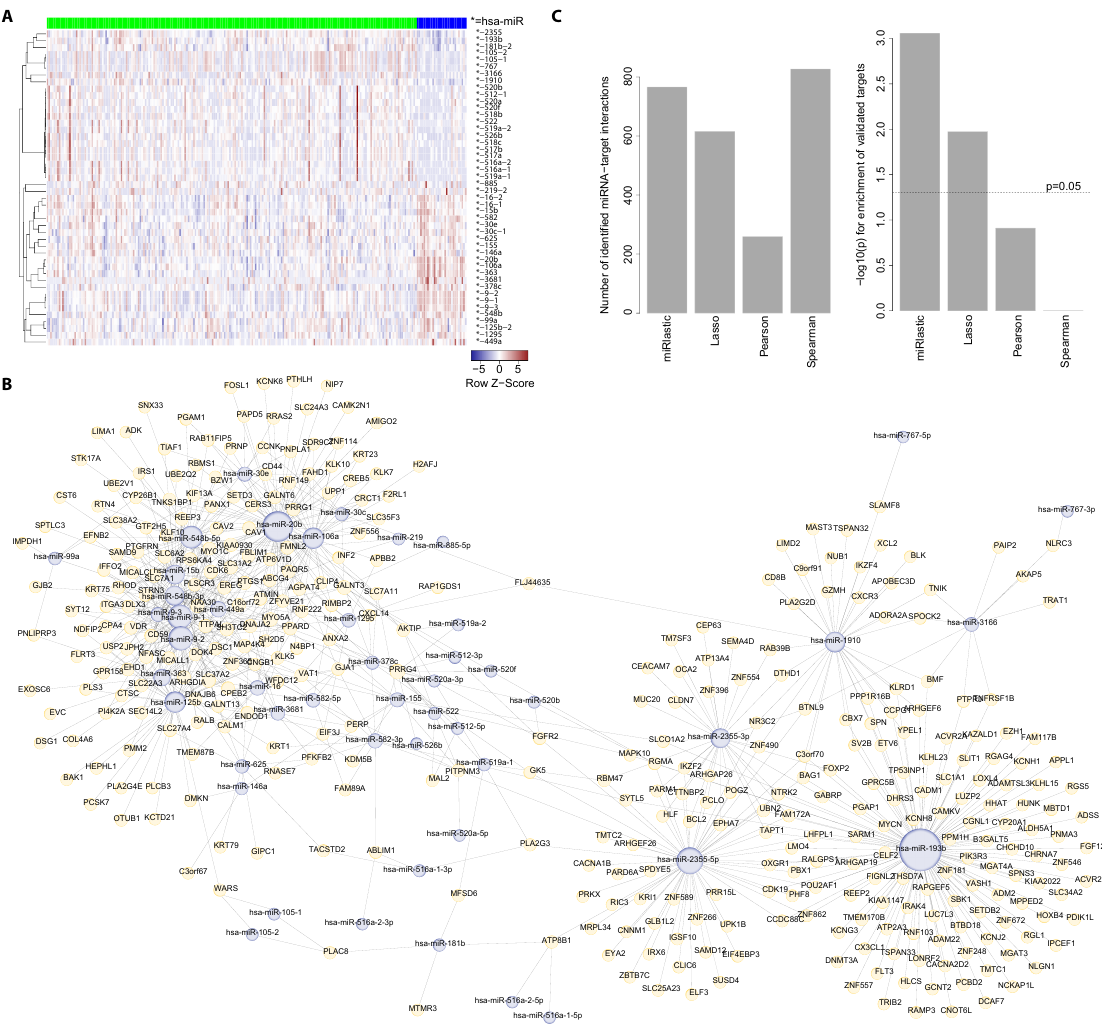
Figure 5. mi-/mRNA regulatory network inference in HNSCC samples. ( A ) 44 miRNA expression profiles show differential expression between HPV+ (blue) and HPV- (green) patients; ( B ) mi-/mRNA regulatory network generated by our inference algorithm. The network consists of 766 regulations between 44 miRNAs (light blue) and 16,617 genes (light yellow). The edges represent miRNA-target relationships in the context of the TCGA HNSCC cohort; ( C ) Performance evaluation of the mi-/mRNA associations inference module. The left bar plot indicates the number of mi-/mRNA interactions detected by our approach, lasso, Pearson and Spearman. The right bar plot shows the − log10-transformed p -values when testing for enrichment of experimentally validated targets within the results of each method. We provide an interactive representation of this network at http://icb.helmholtz-muenchen.de/mirlastic/hnscc